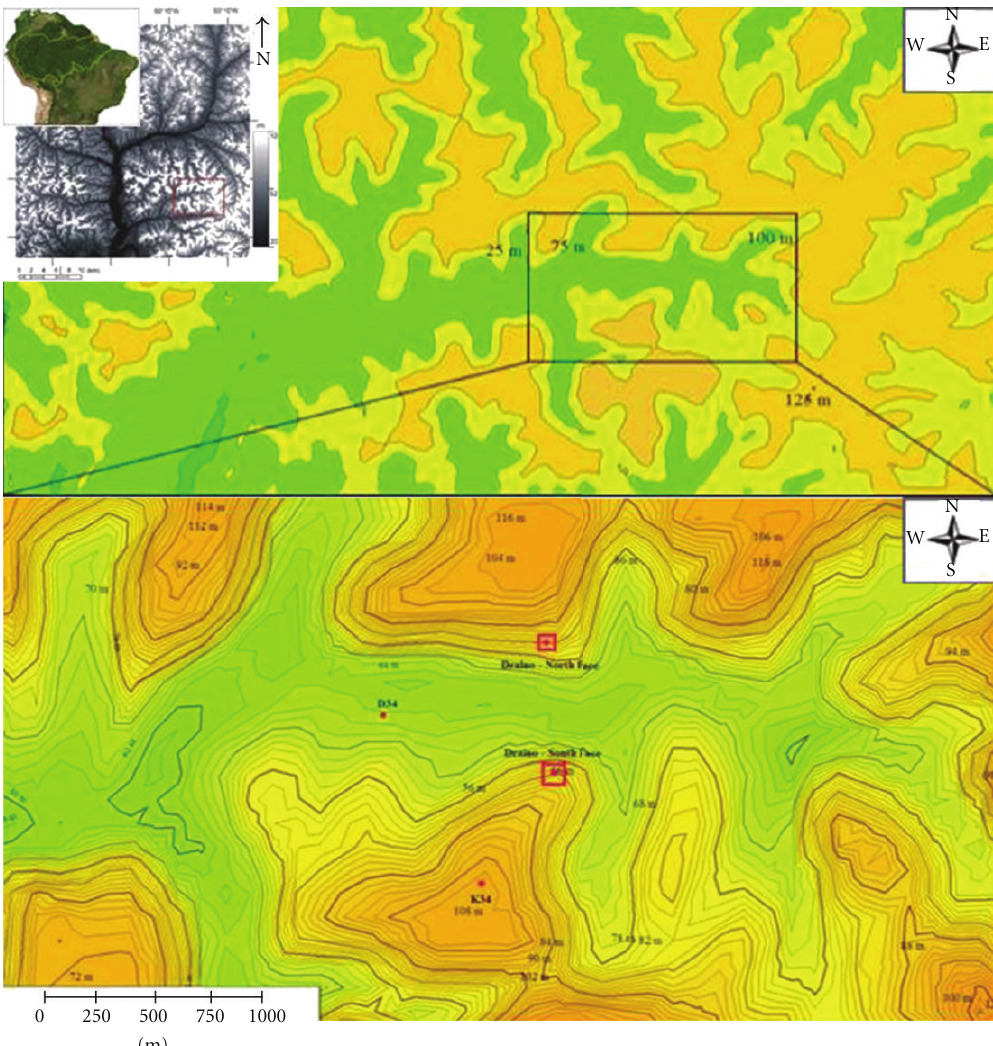
Figure 1: Detailed measurements shows towers’ view in the ZF-2 Ac¸u catchment (East-West valley orientation) from SRTM-DEM datasets. The large view in the above panel and below panel: the points of measurements (B34-Valley, K34-Plateau, and subcanopy DRAINO system measurements over slopes in south and north faces (red